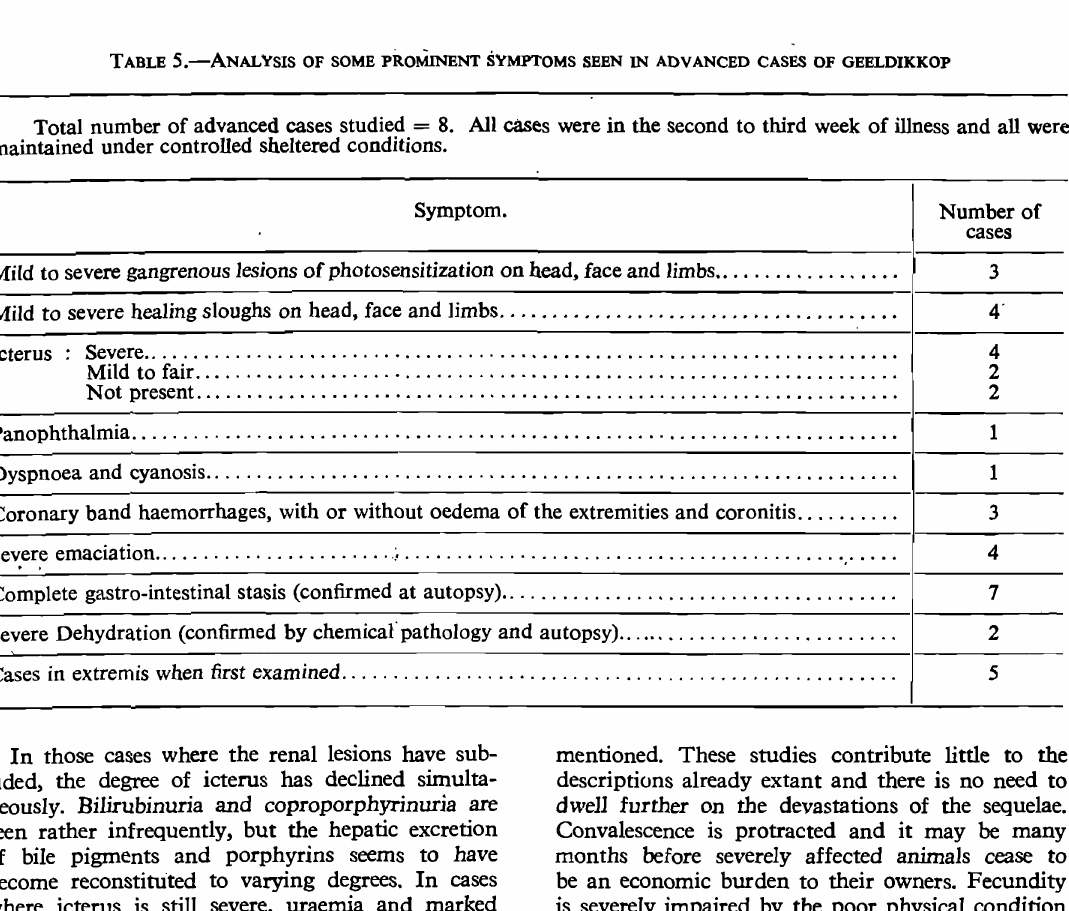
TABLE 5.-ANALYSIS OF SOME PROMINENT SYMPTOMS SEEN IN ADVANCED CASES OF GEELDIKKOP